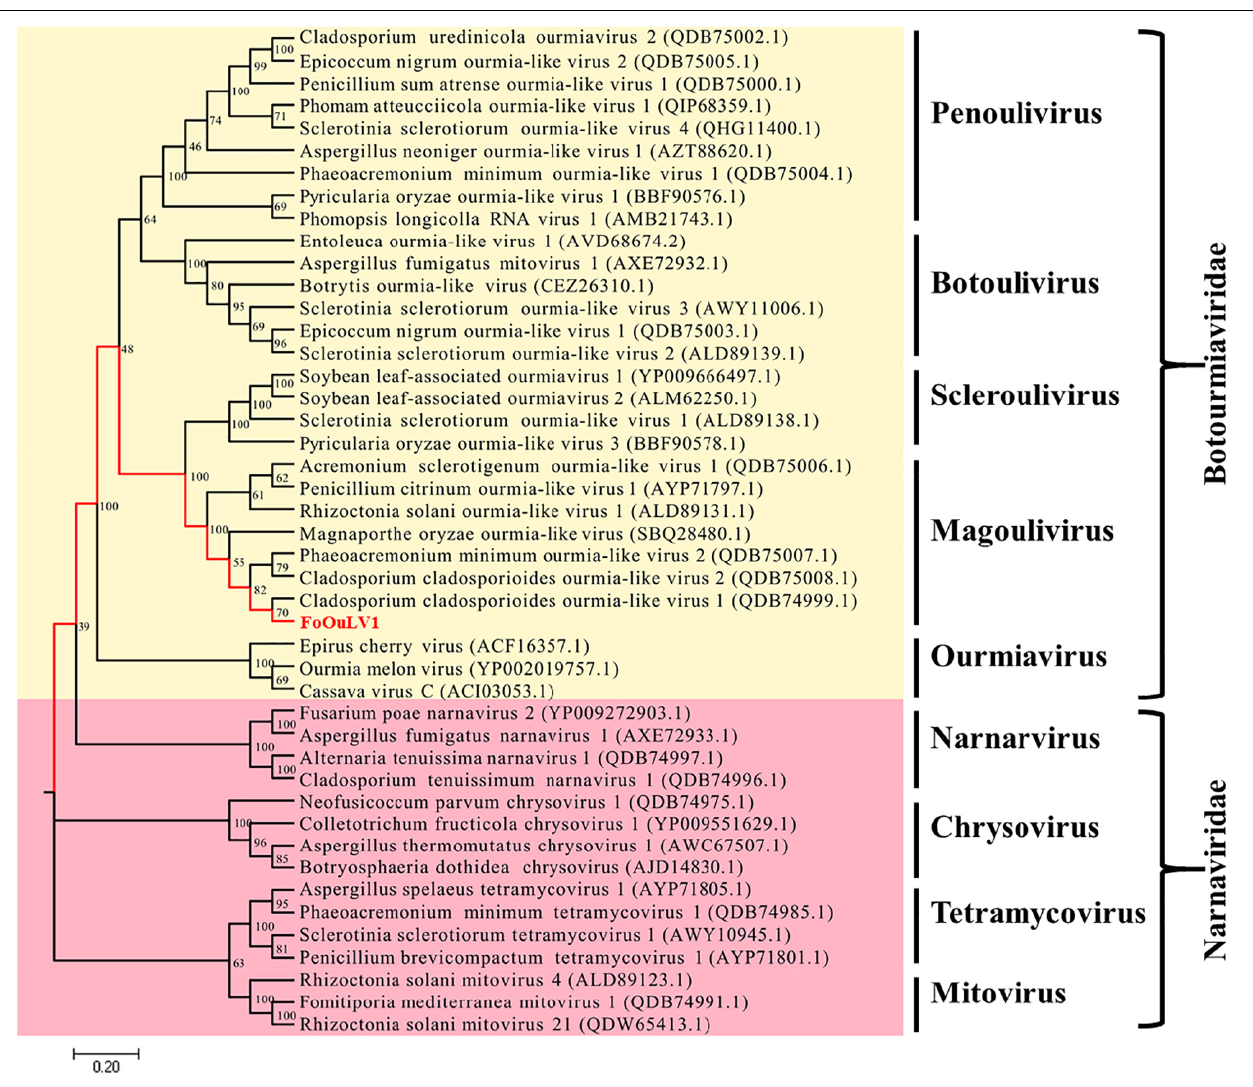
onto bitter gourd seedlings at the stage of two or three